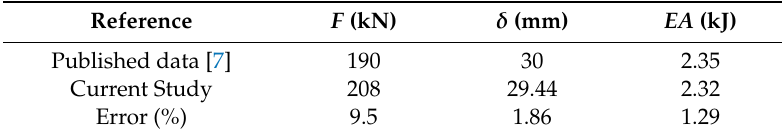
Table 5. Finite element model validation.